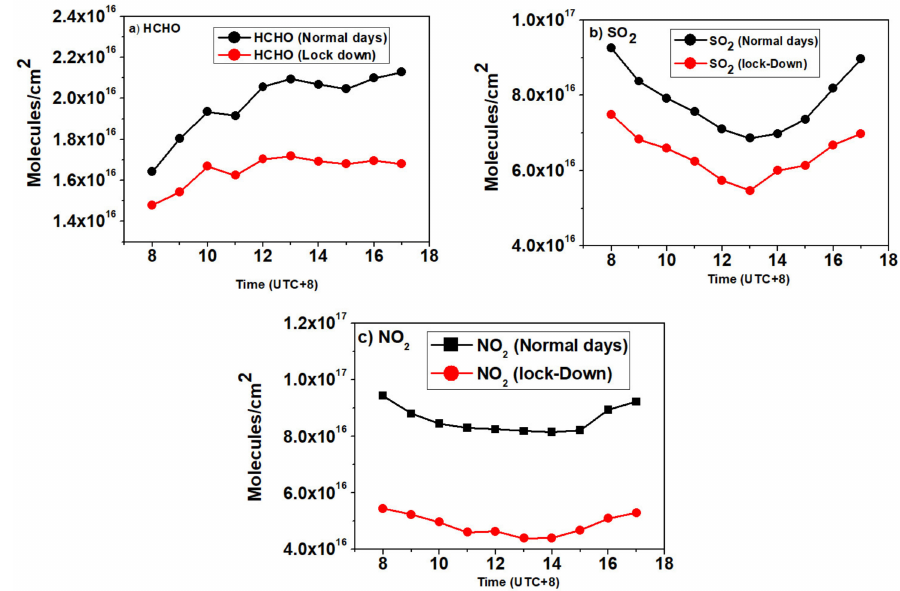
Figure 7. Diurnal variation in hourly mean VCDs of ( a ) HCHO, ( b ) SO 2 , and ( c ) NO 2 from MAX-DOAS averaged during normal days and the lockdown